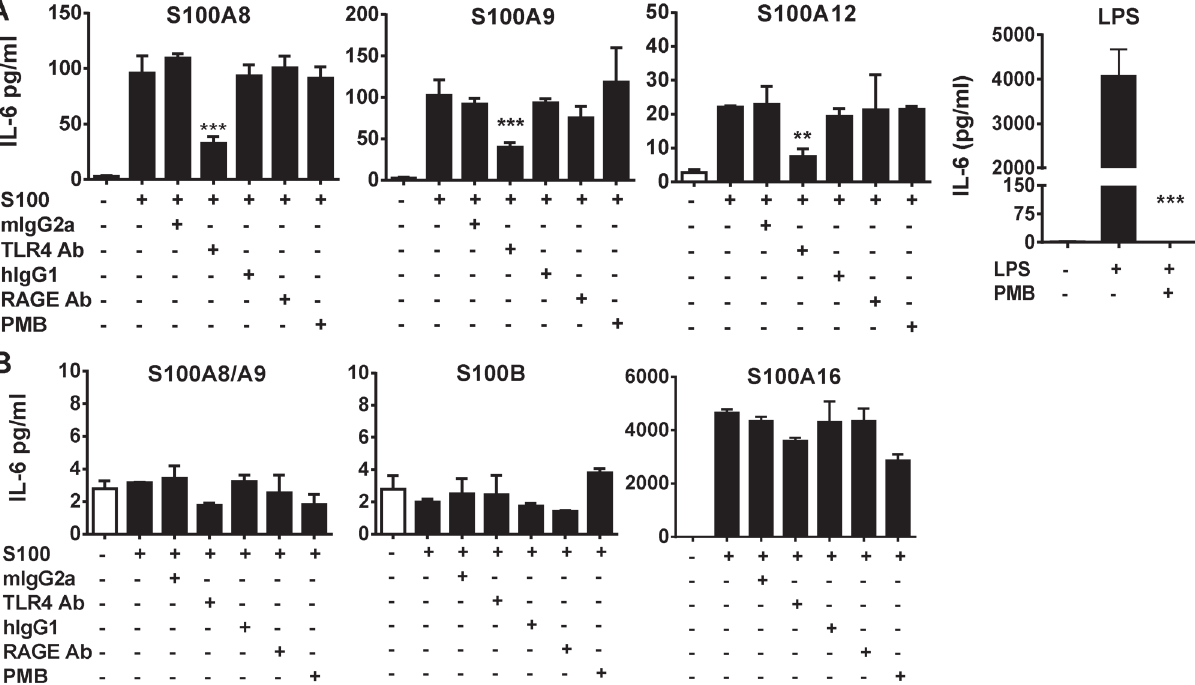
Fig 1. TLR4 but not RAGE is necessary for calgranulin-mediated proinflammatory cytokine induction, but other S100s exhibited variable cytokine responses. Human PBMCs were stimulated with 10 μ g/ml of human S100 preparations and levels of IL-6 (and other cytokines) were measured after 16 h in culture. (A) Cells were stimulated with low endotoxin preparations of calgranulins (S100A8, S100A9 or S100A12) or LPS and were treated with either nil, control Ab, anti-hTLR4, anti-RAGE Abs or Polymyxin B (PMB). (B) Cells were stimulated with S100A1, S100A16, S100B and S100A8/A9 and were similarly treated with nil, control Ab, anti-hTLR4 Ab, anti-RAGE Ab, or Polymyxin B. Representative data from one of three experiments is shown. Individual experiments were performed in triplicate and mean ± SD are given. Unpaired T-tests was used to determine if the test antibody differed significantly from their respective control Abs following stimulation, and if the polymyxin treatment differed from no treatment following stimulation ( * P < 0.05, ** P < 0.01, *** P < 0.001).